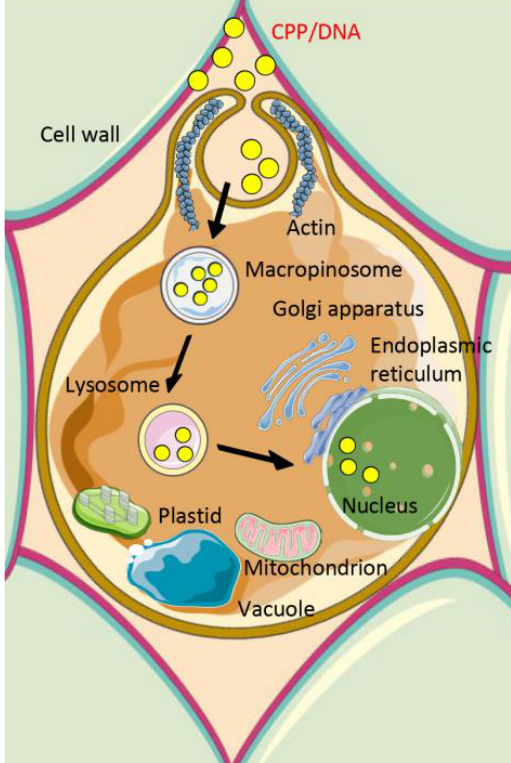
Figure 3. Schematic diagram of macropinocytosis.